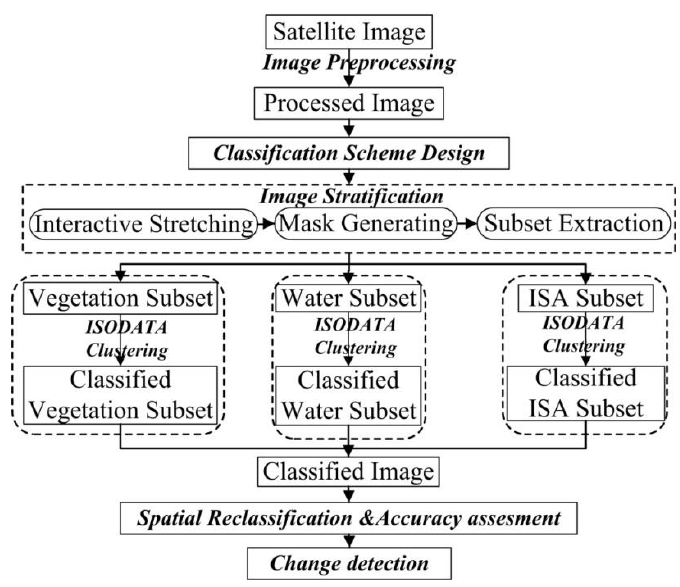
Figure 2. Seven steps of methodology.